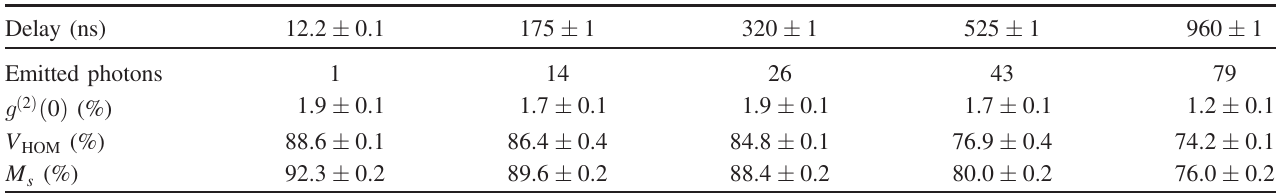
TABLE II. Visibility (indistinguishability) of two photons emitted by the QDSPS as a function of the delay between their emission. The g ð 2 Þ ð 0 Þ value is also